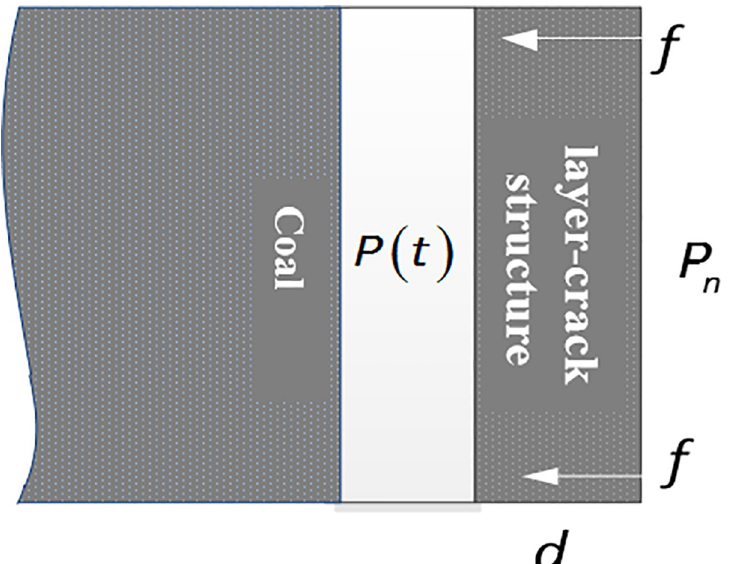
Fig 15. Schematic diagram of the simplified model of spallation